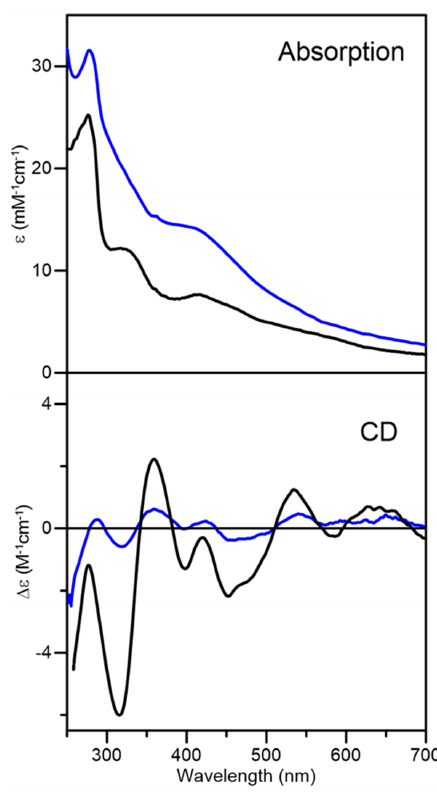
Figure 5. Room temperature UV-visible absorption and CD spectra of At ISCA1a/2 heterodimer. The [2Fe-2S] 2+ cluster-bound as-isolated At ISCA1a/2 (black lines) and [4Fe-4S] 2+ cluster-bound reconstituted At ISCA1a/2 (blue lines) are shown. All ε and Δε values are based on ISCA1a/2 heterodimer concentration. The vibrational properties of the [2Fe-2S] 2+ center in ISCA1a/2 were characterized by resonance Raman spectroscopy, which provides information on cluster type and ligand environment. Resonance Raman spectra of as-purified [2Fe-2S] 2+ cluster-bound ISCA1a/2 in the Fe-S stretching region (240–450 cm − 1 ), obtained using 458 and 488 nm laser excitation, showed an intense band at 288 cm − 1 and additional major bands at 334 cm − 1 , 352 cm − 1 , 398 cm − 1 and 421 cm − 1 (Figure 6). The Fe-S stretching frequencies for the [2Fe-2S] 2+ cluster in ISCA1a/2 are very similar to those of the all-cysteine ligated [2Fe-2S] 2+ centers in chloroplastic ferredoxins and the Azotobacter vinelandii ( Av ) Nif IscA